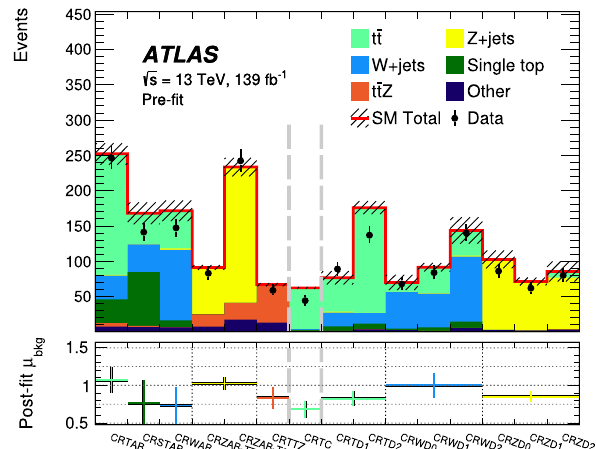
Fig. 8 A summary of the normalisation factors determined from the various background-only fits. The total number of data events (points) and the SM expectation (stacked histograms) are shown in each control regionbeforethefit.TheuncertaintyassociatedwiththeSMexpectation includes the combination of MC statistical uncertainties, theory-related and detector-related systematic uncertainties. The normalisation factor applied to each background source ( μ bkg ) after the fit and respective uncertainty, including the combination of MC statistical uncertainties, theory-related and detector-related systematic uncertainties, is shown in the lower panel. The control regions included in the SRA–B, SRC and SRD fits are separated by vertical dashed